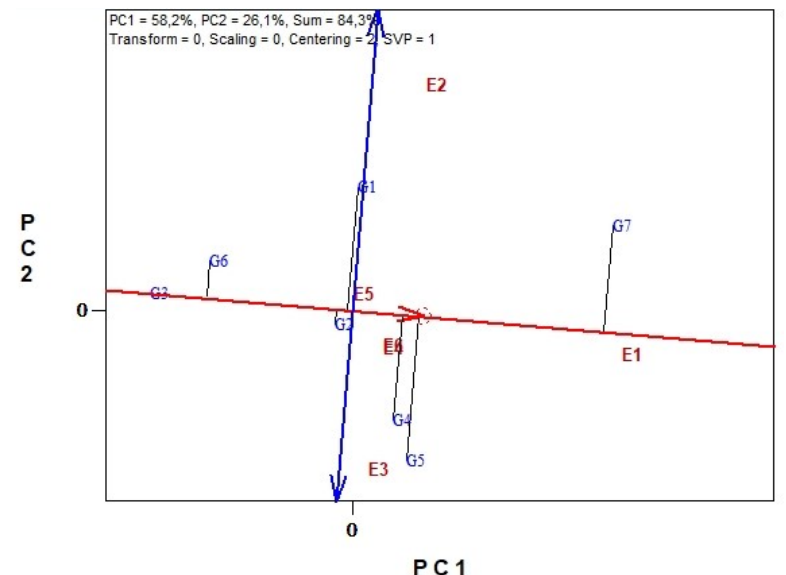
Figure 3. “Discriminating power vs. representativeness” view of the GGE biplot based on biomass yield on 7 V. sativa genotypes in six environments. Environment 4 and Environment 6 coincide.